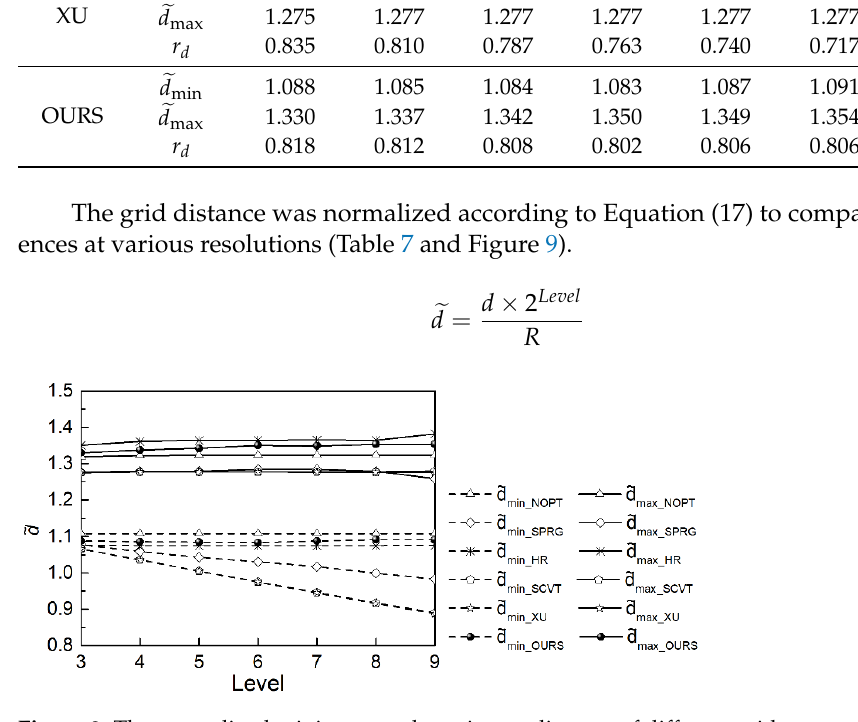
Figure 9. The normalized minimum and maximum distance of different grids. Ratios between the minimum and maximum distances, r d = d min / d max , of different grids at different resolutions are calculated in Table 7 and presented in Figure 10.